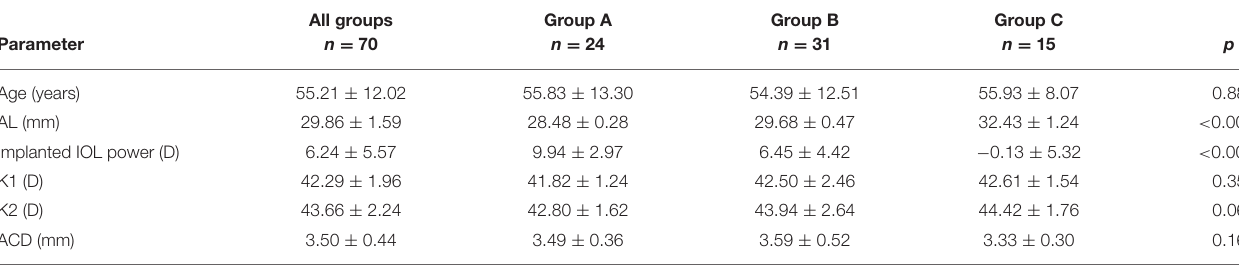
TABLE 1 | The clinical data of all patients and 3 subgroups.